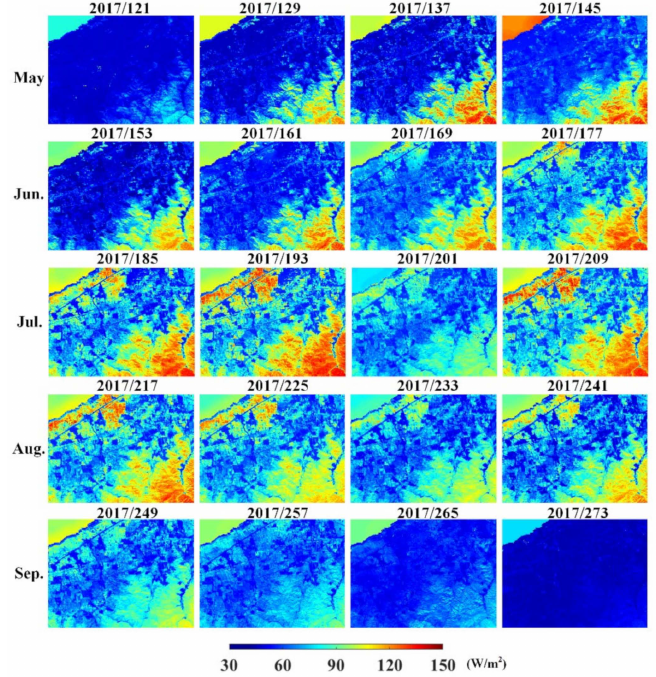
Figure 9. Spatial time series (every 8 days) of LE product based on the ERTFM in the growing season (from May to September 2017).